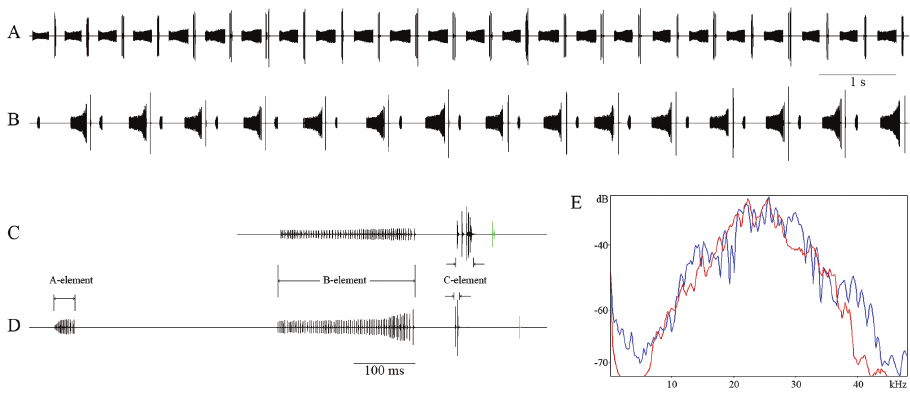
Figure 4. Acoustic signals analysis in two close–related species: A, B oscillographic pattern of male calling song C, D a detailed syllable and the female response (marked with green) E spectrum (function: Hanning window, size: 512). A, C, E red line Isophya bucovinensis sp. n. B, D, E blue line Isophya nagyi